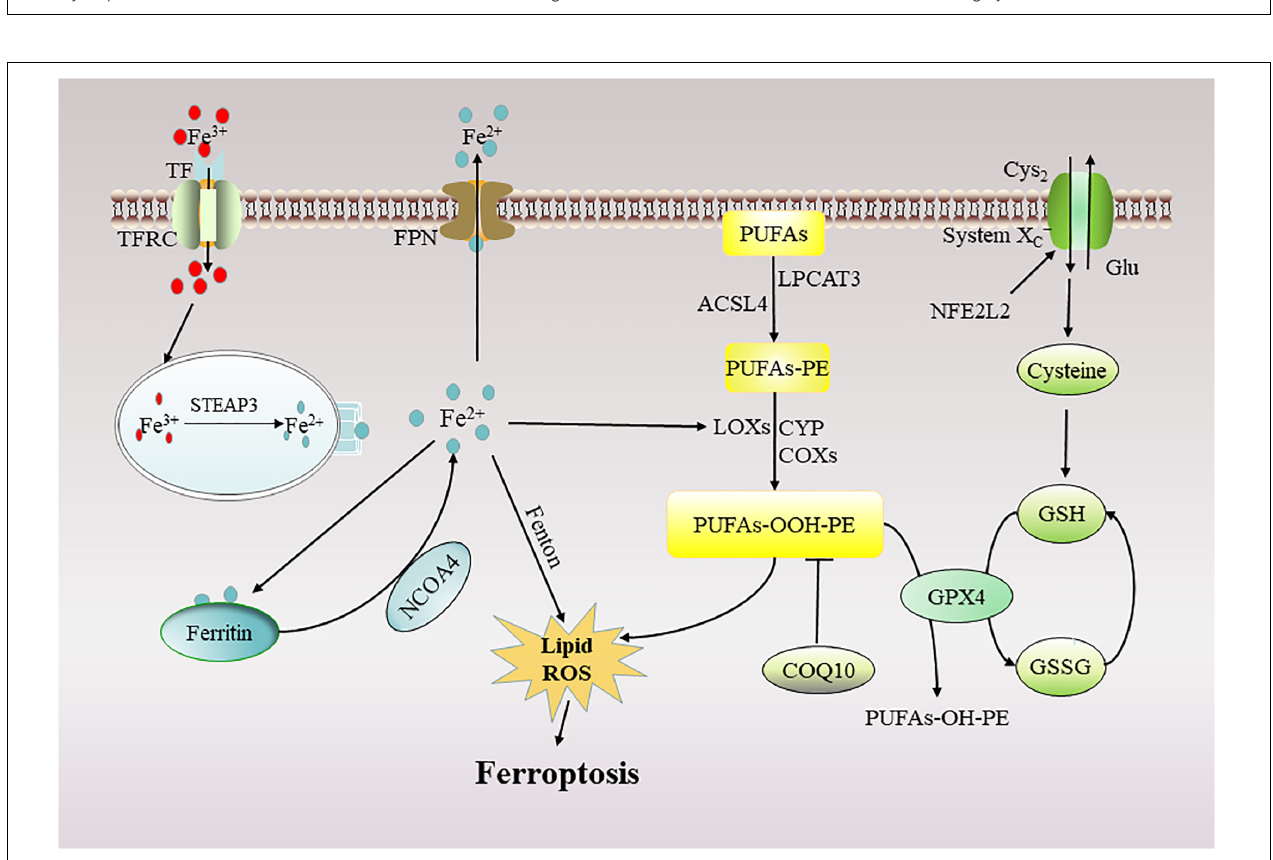
FIGURE 2 | Mechanism of ferroptosis. Ferroptosis can occur in two major pathways: (1) through the accumulation of ferrous ions and (2) through the accumulation of lipid peroxides. TF, transferrin; TFRC, transferrin receptor; FPN, ferroportin; NFE2L2, the nuclear factor erythroid 2-like 2; STEAP3, 6-transmembrane epithelial antigen of the prostate 3; NCOA4, nuclear receptor co-activator 4; ROS, reactive oxygen species; GSH, glutathione; GPX4, glutathione peroxidase 4; PUFAs, polyunsaturated fatty acids; ACSL4, acyl-CoA synthetase long-chain family member 4; LPCAT3, lysophosphatidylcholine acyltransferase 3; CoQ10, Coenzyme Q10; Glu, glutamate; Cys 2 , Cystine; LOXs, lipoxygenase; CYP, cytochrome P450; COXs, Cyclooxygenases.